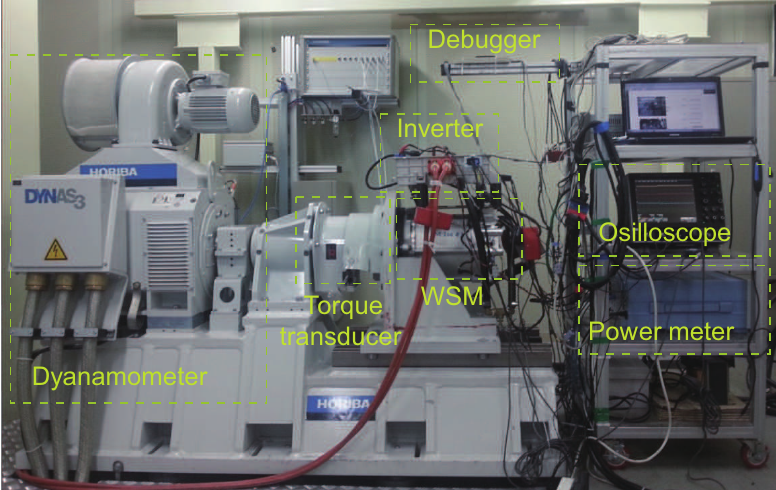
Figure 11. Experiment environment for testing sensorless control: the dynamometer, inverter, debugger, osilloscope, torque transducer, and WSM.